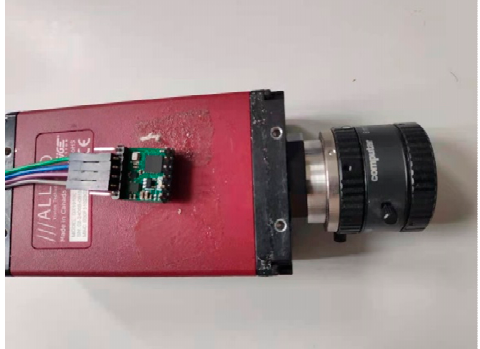
Figure 8. The relationship between the camera and the gyroscope.